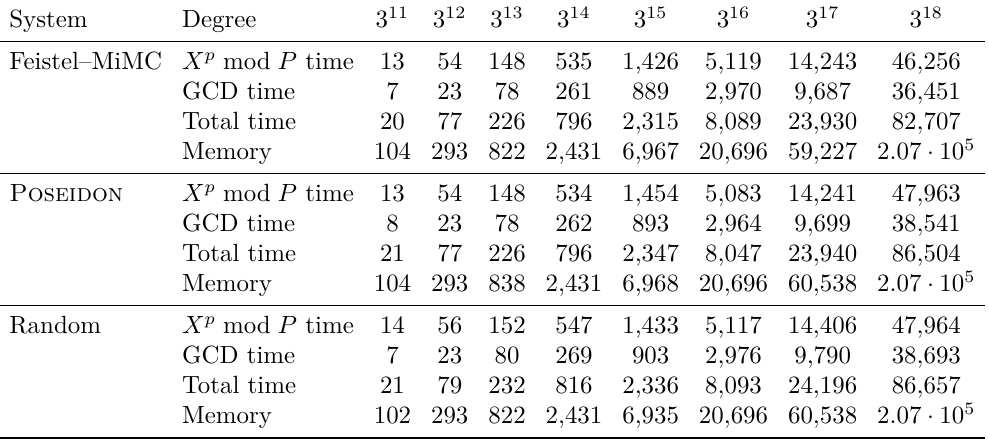
Table 4: Benchmarks of univariate root finding with NTL (using 1 core of an Intel Xeon E7-4860), for Poseidon , Feistel–MiMC and random polynomials of several degrees, with 𝑝 = 18446744073709551557 ≈ 2 64 . Times are given in seconds and memory usage in MegaBytes.